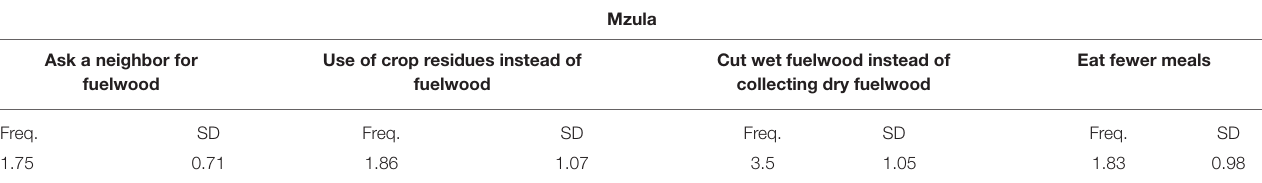
TABLE 5 | Results of the frequency assessment of Mzula.